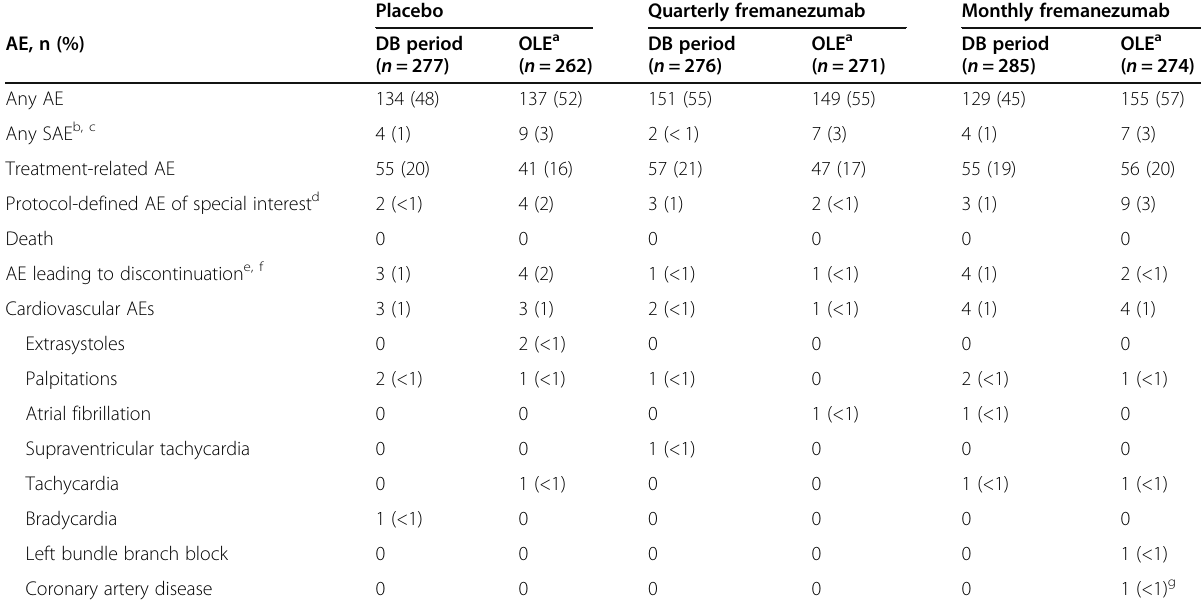
Table 2 AEs in the DB Period and the OLE (Safety Analysis Set)